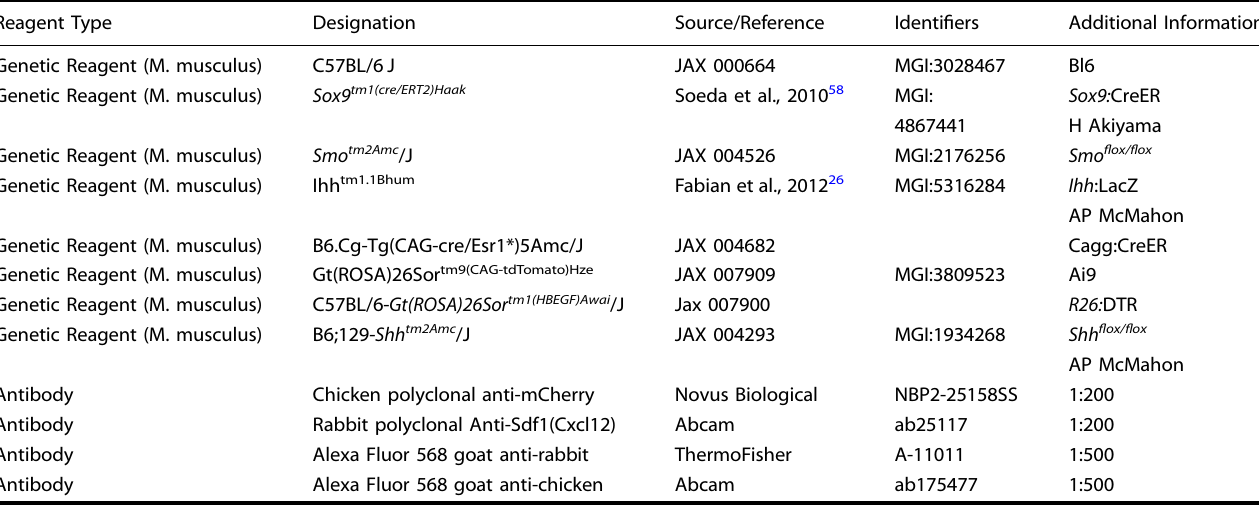
Table 1. List of reagents used in this